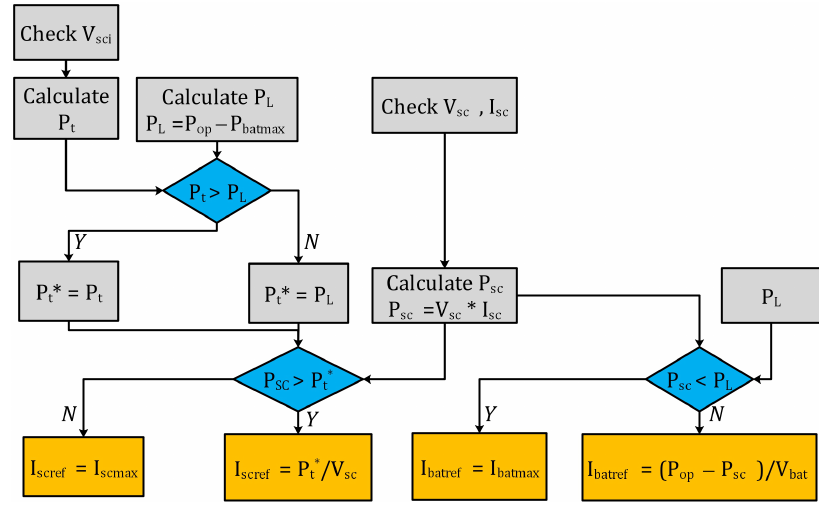
Figure 8. Energy management system of the proposed WPT